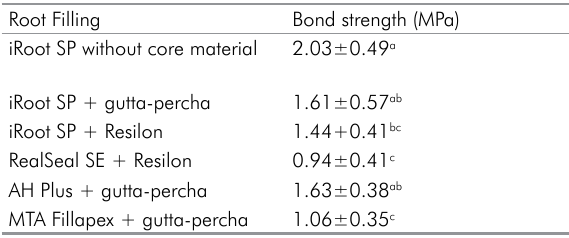
Table. Push-out bond strength values (MPa, mean±standard deviation) of the experimental groups. Within each column, values with different lowercase superscript letters are signifi- cantly different at p<0.05 (One-way ANOVA and Tukey